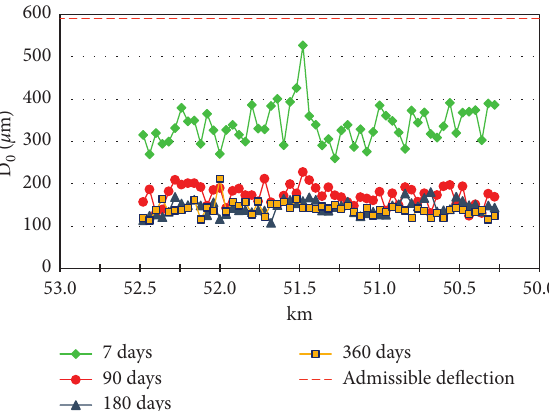
Figure 9: Maximum deflection D 0 measured with FWD after 7, 90, 180, and 360days of the trial section